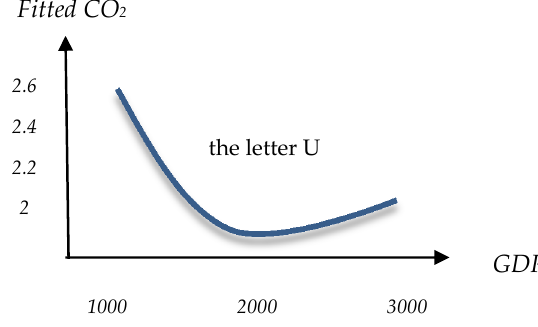
Figure 1. EKC hypothesis for Poland, Own study based on [100].